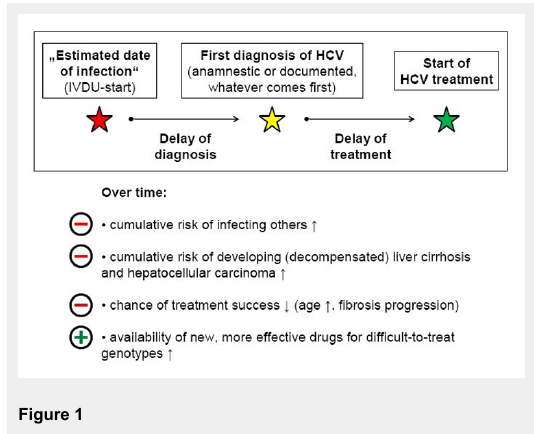
Delay of HCV diagnosis and treatment.